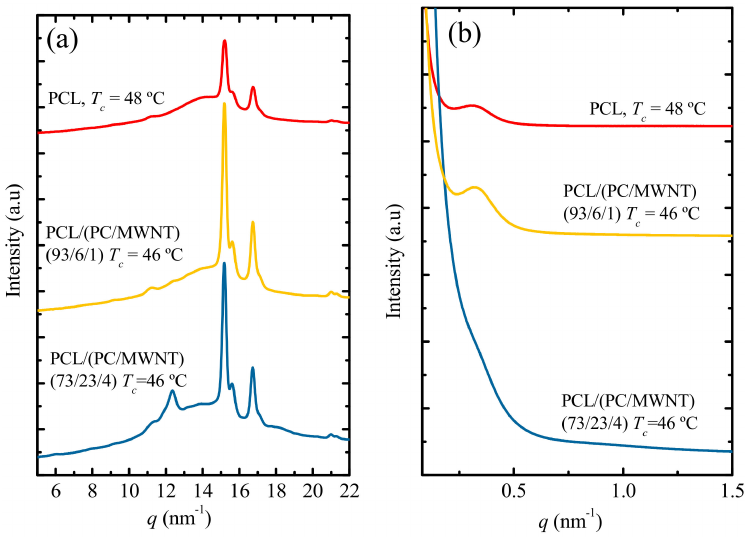
Figure 2. ( a ) WAXS (Wide Angle X-ray Scattering) diffractograms taken at selected isothermal temperatures; ( b ) SAXS (Small Angle X-ray Scattering) patterns taken at the same temperatures as in ( a ).